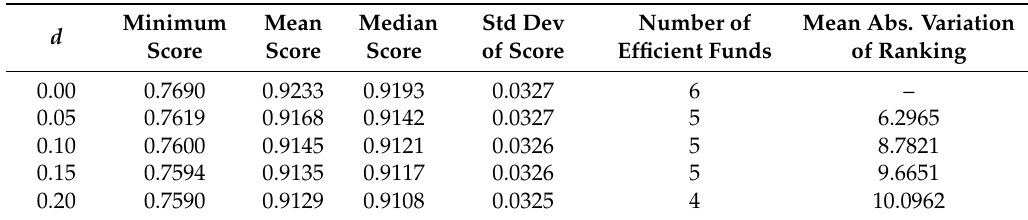
Table 8. Main results for the VW restrictions with constraints only on the target DMU in the case of asymmetric bounds and T = 1. Summary statistics on the performance scores (minimum, mean and median values, standard deviation), number of efficient funds and mean absolute variation (divided by 2) of the ranking positions.